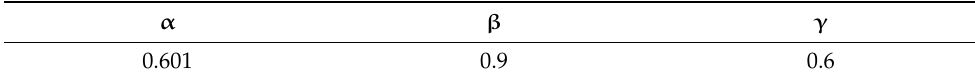
Table 2. The number of α , β and γ